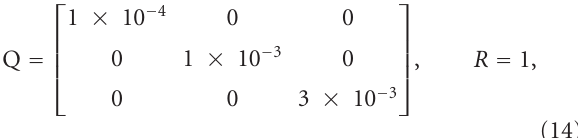
Figure 4: Residual analysis.